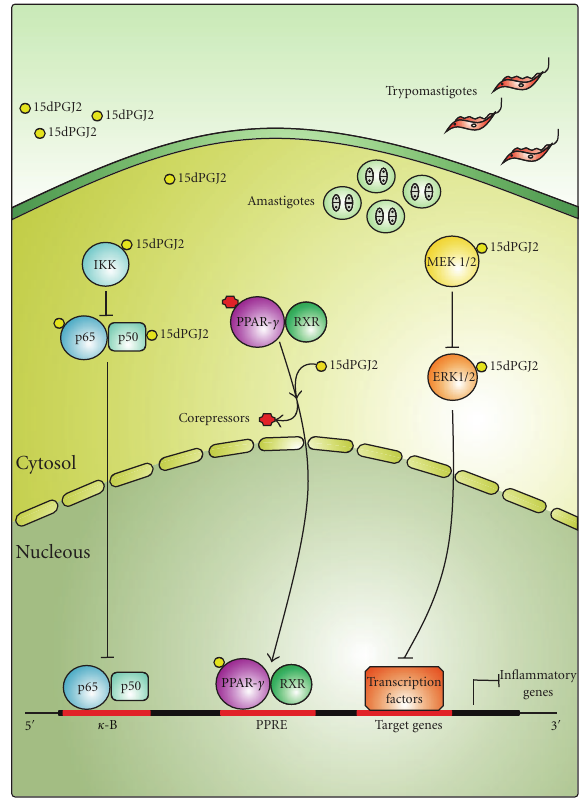
Figure 2: Anti-inflammatory actions of 15dPGJ2 in T. cruzi - infected cardiomyocytes. 15dPGJ2 can exert its e ff ects by binding to PPAR- γ or through interaction with intracellular targets like NF- κ B-signaling pathway and Erk MAP kinase cascade. By PPAR- γ -dependent mechanisms, the 15dPGJ2-PPAR- γ complex forms a heterodimer with nuclear retinoid X receptor (RXR) to recognize PPAR-response elements (PPREs) in the promoter region of the target genes thereby stimulating their transcription. In the cytosol, 15dPGJ2 can also bind specific residues in IKK, p50, or p65 of the NF- κ B-signaling pathway, or MEK1/2 and Erk1/2 in the MAP kinase pathway leading to functional inactivation of inflam- matory target genes. The consequent inhibition of inflammatory factors/mediators by 15dPGJ2 promotes an increase in the number of intracellular